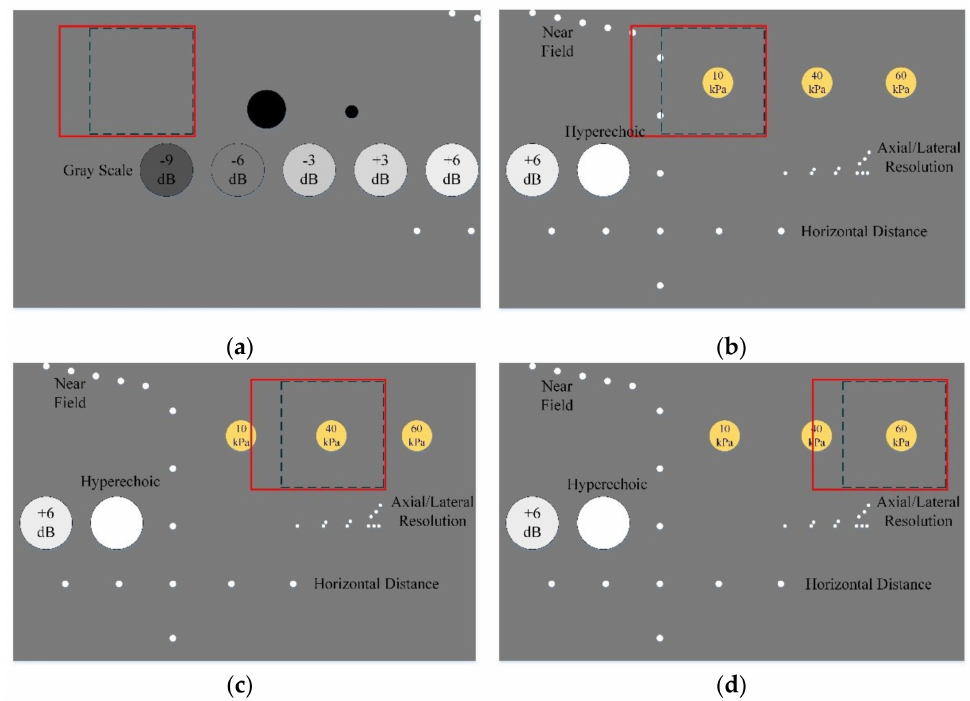
Figure 1. The selected experimental area in 040GSE ultrasound phantom. ( a ) The selected experimen- tal area of homogeneous region. ( b ) The selected experimental area containing a 10 kPa inclusion. ( c ) The selected experimental area containing a 40 kPa inclusion. ( d ) The selected experimental area containing a 60 kPa inclusion.